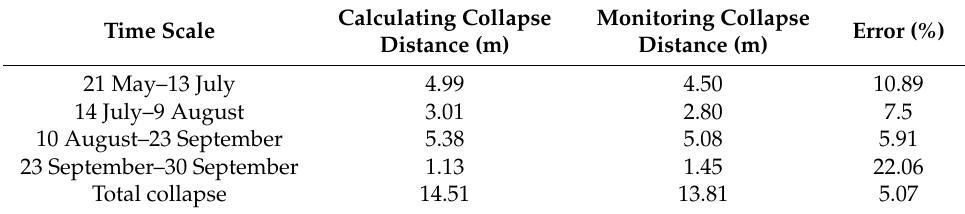
Table 6. Numerical results, field measurements and errors for surveying Section 2 of Figure 1.